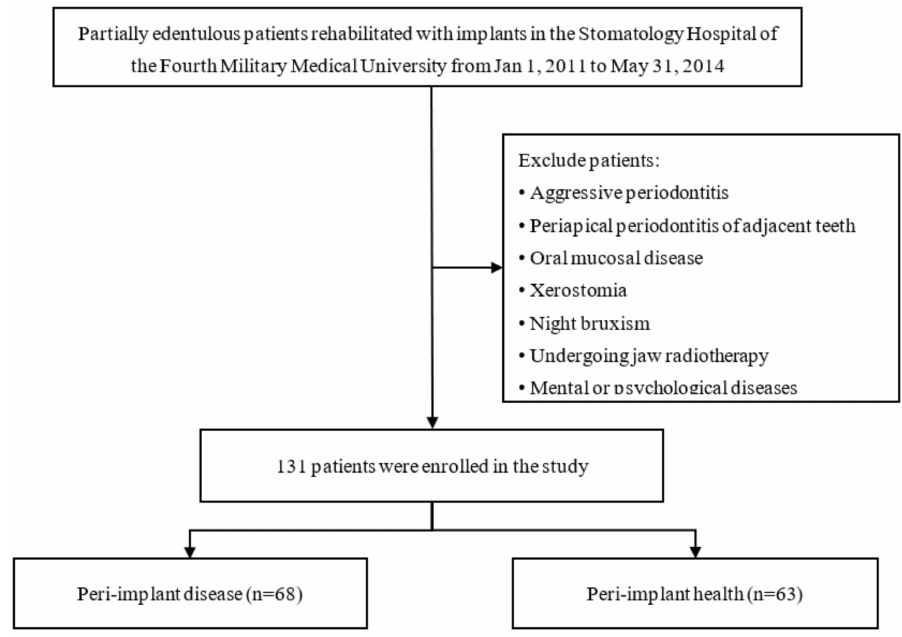
Figure 1. Flow chart of patient